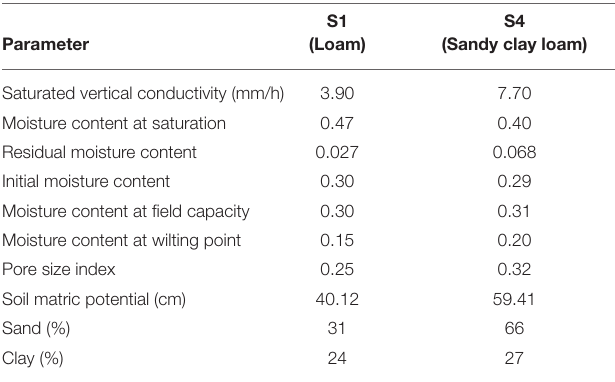
TABLE 3 | Comparison of soil types for S1 and S4.